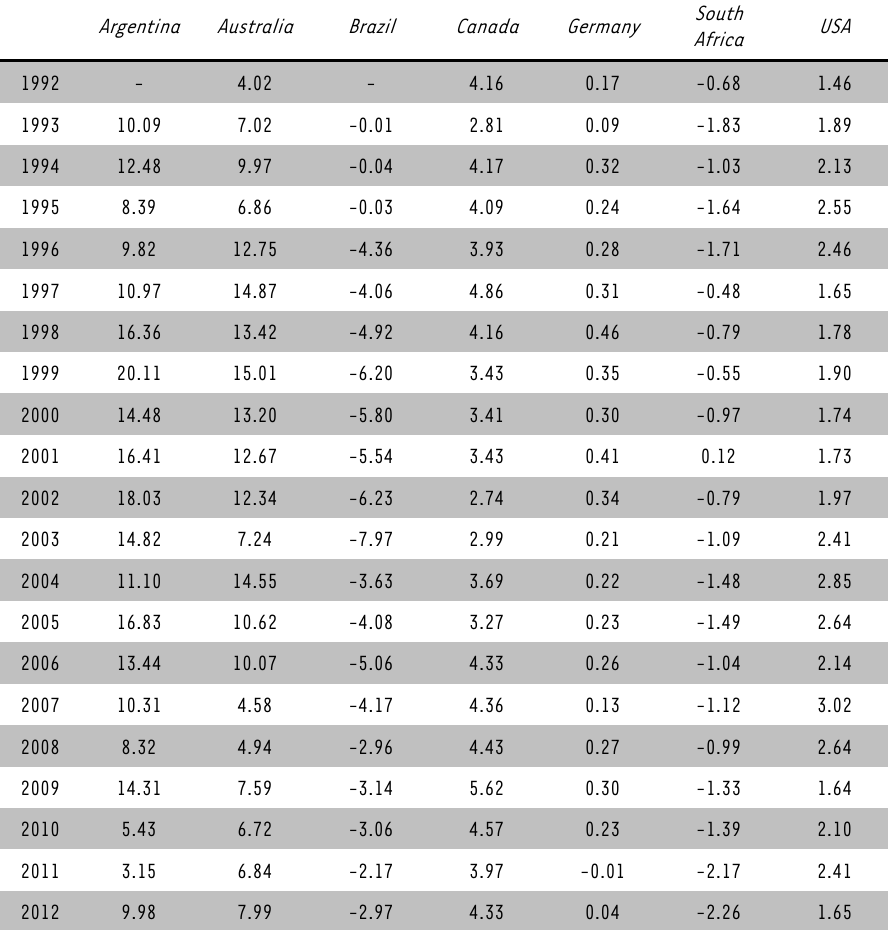
TABLE 2: RTA: Unprocessed Wheat: Global